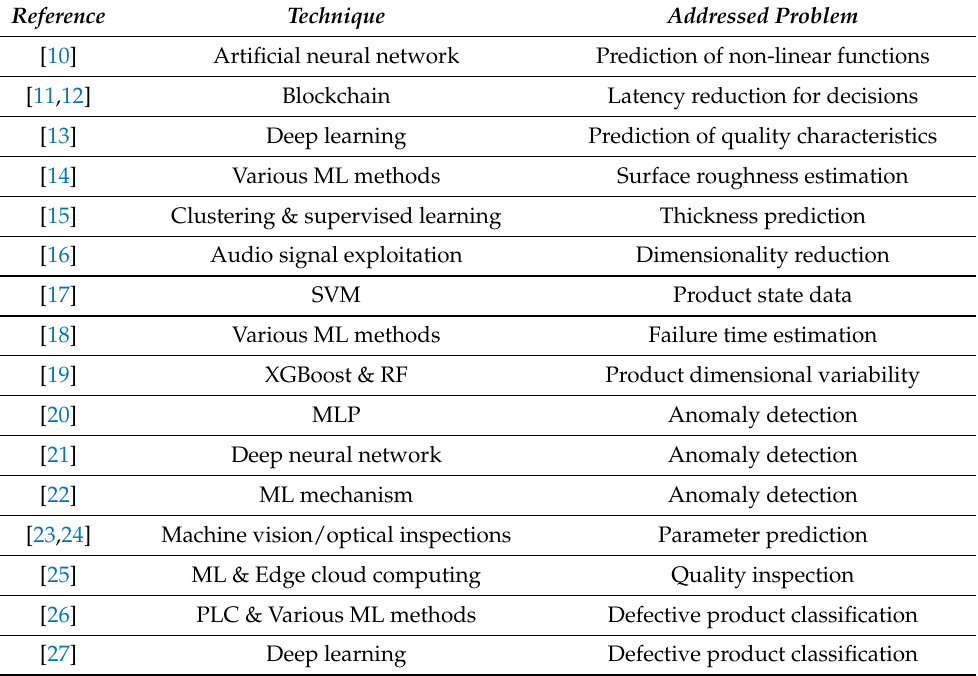
Table 1. Indicative research for the production